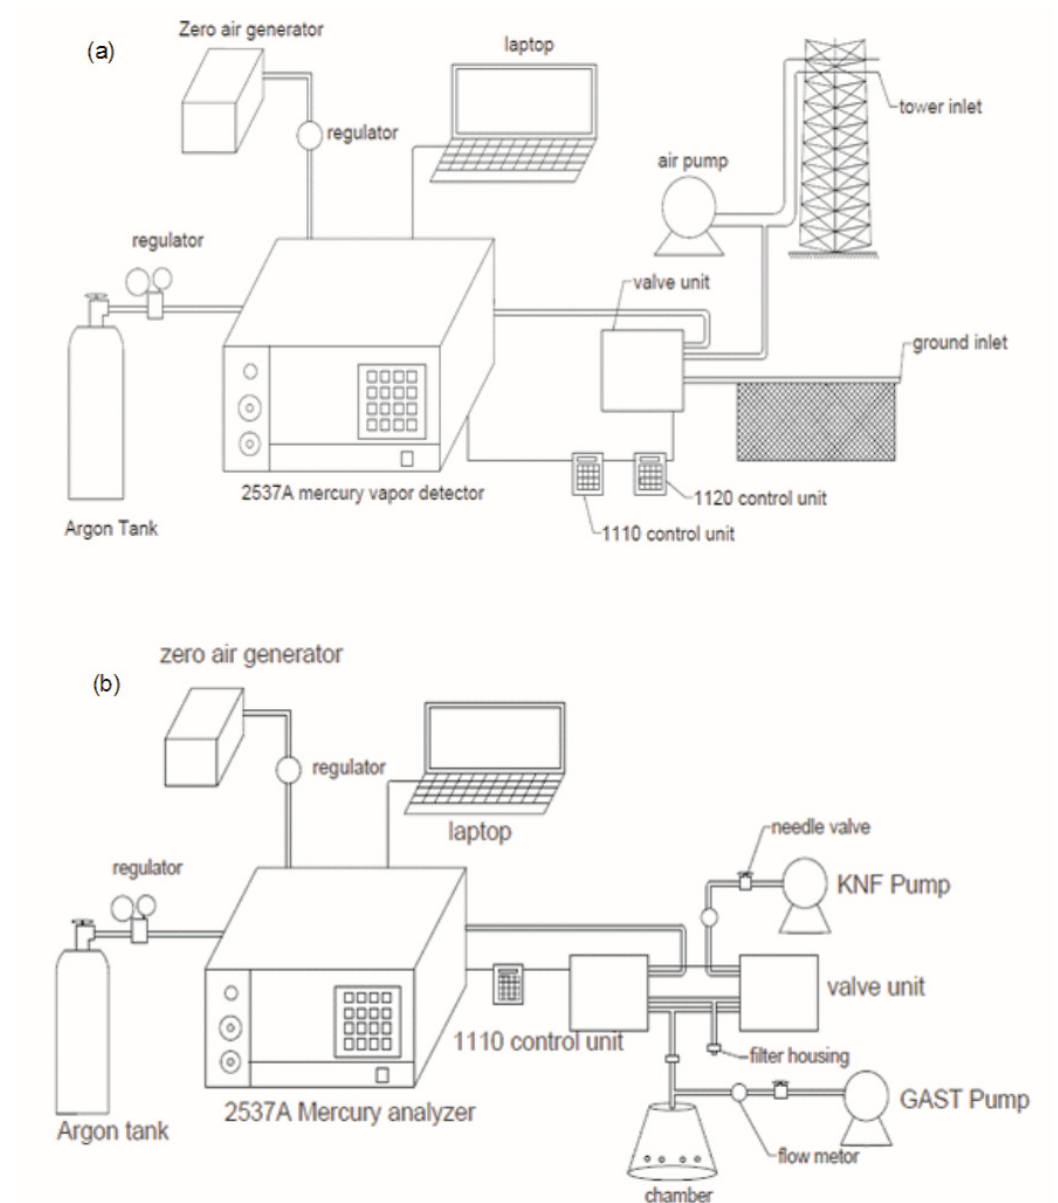
Figure 2. Schematic diagram of atmospheric total gaseous mercury (TGM) measurement system ( a ) and soil evasion measurement system ( b ) used in this study.